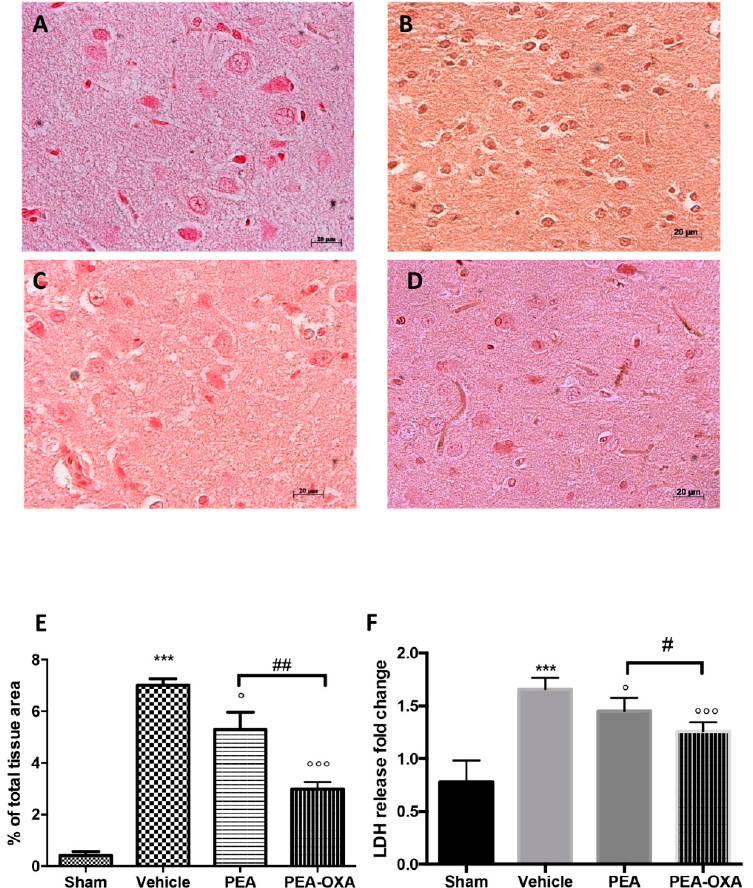
Figure 5. Efficacy of PEA-OXA on caspase 3 expression and LDH levels (induced by transient MCAo). An immunohistochemical analysis of caspase 3 ( E ) was performed. A marked increase in its